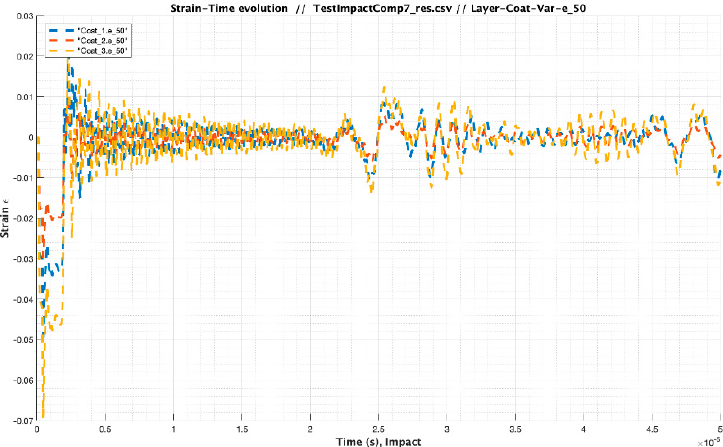
Figure 34. Strain-Time evolution for Cases 1–3 at middle coating layer, 50% thickness, considering the substrate-filler as semi-infinite with variation in droplet velocity.